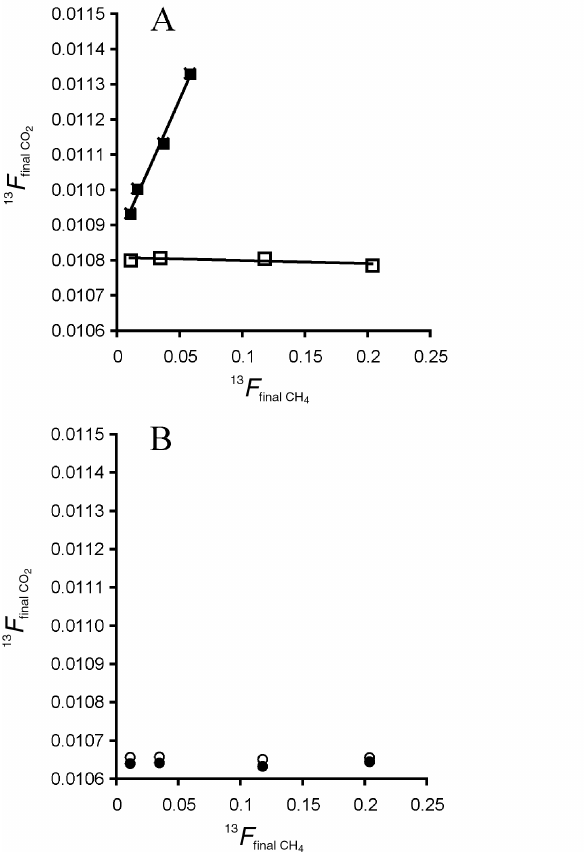
Figure 2. The 13 C fractional abundance ( 13 F ) of a culture bottle’s CO 2 after incubation versus 13 F of final CH 4 tracks methane oxidation to CO 2 . (A) The 13 F CO 2 in culture bottle headspace following incuba- tion versus 13 F of the final methane in each bottle for Methanosarcina acetivorans cultures( (cid:2) ) grown with trimethylamineand for identical, but not inoculated, control bottles ( (cid:3) ). The difference in slopes be- tween the cultured(8.0 × 10 –3 ) and controlsamples(–8.6 × 10 –5 ) de- termined the amount of methane oxidation in the experiment. (B) Results from Archaeoglobus profundus ( (cid:4) ) and control samples ( (cid:5) ) showing no directrelationshipbetween the extentof finalmethaneen- richment and 13 F of final CO 2 , indicating no methane oxidation by the